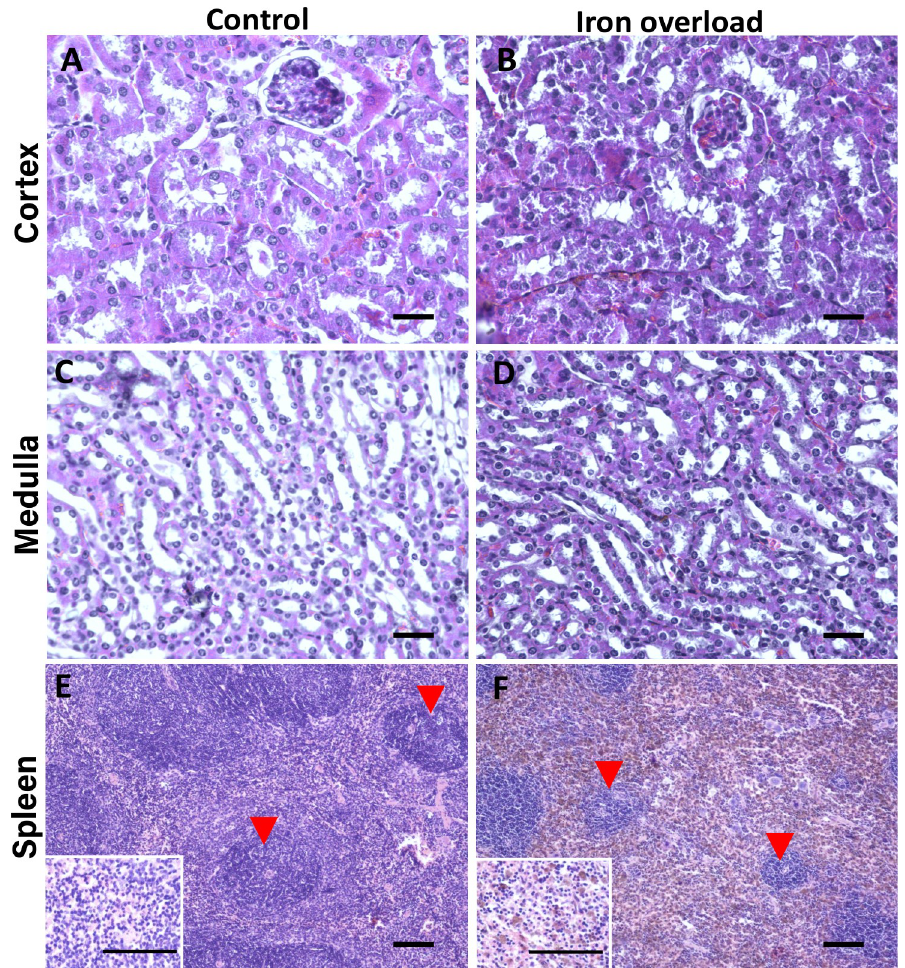
Fig 1. PIO did not cause morphologic kidney damage, but affected the spleen. Fixed kidney and spleen sections from control and iron-loaded mice were histologically stained (H&E) and imaged. No damage was observed in kidney sections of iron-loaded mice (B and D) compared to the control sections (A and C) . However, iron accumulation caused damage to the spleen as can be evaluated by moderate degree of hemosiderosis (seen as brownish pigment in the red pulp of section F compared to E ), and by a mild depletion of lymphocytes in the white pulp (indicated by red arrowheads); the inserts in the left corner of E and F are higher magnifications of these sections. Scale bar 100 μ m, n = 3 for control and iron-loaded mice